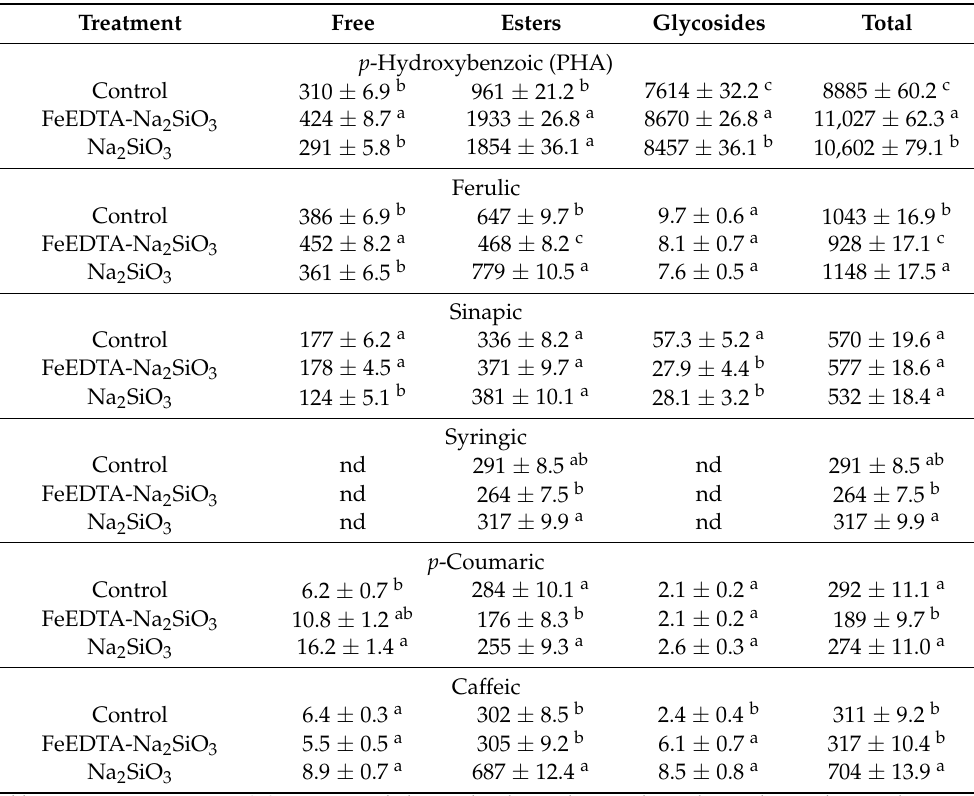
Table 4. The content ( µ g/g DW) of phenolic acids (free, released from ester and O-glycoside forms, and in total) in radish sprouts ( µ g/g DW) treated with elicitors during